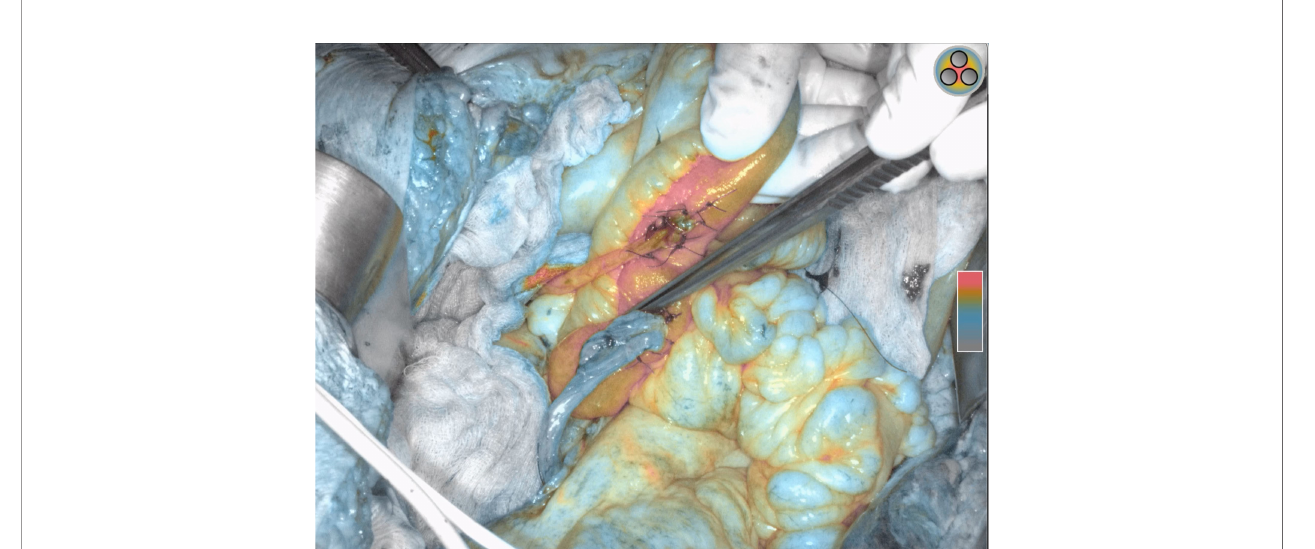
FIGURE 2 | Bricker ileal conduit uretero-enteric anastomoses demonstrating right ureter with optimal indocyanine green (ICG) perfusion (+++) vs. left ureter with poor ICG perfusion (- -